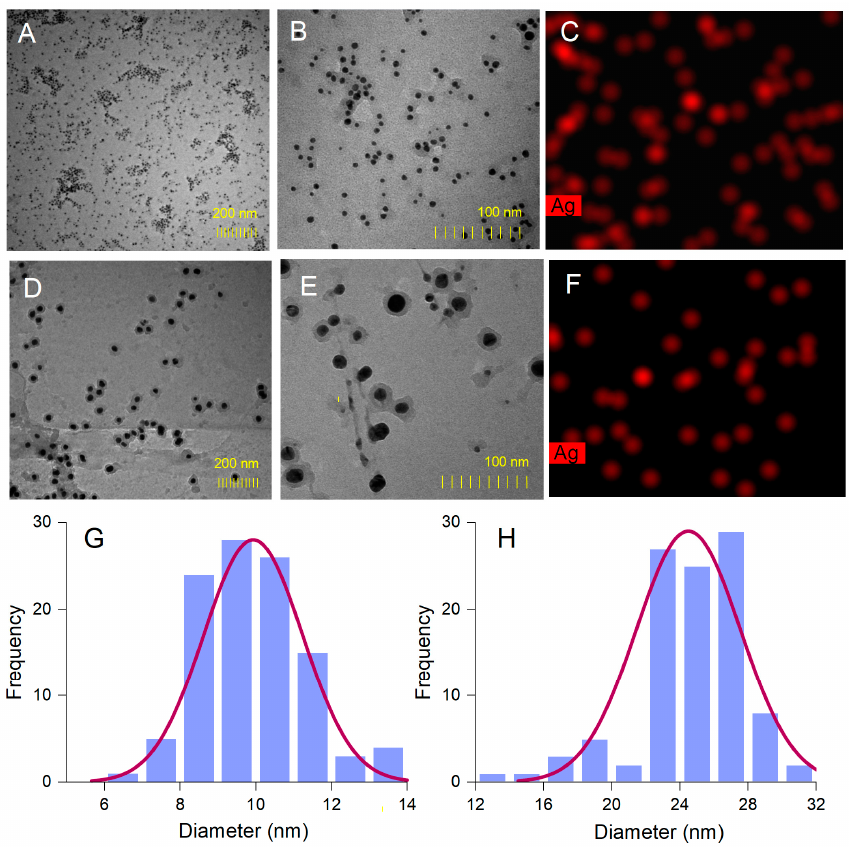
Figure 5. Abies alba bark extract-derived AgNPs: TEM images ( A , B ), TEM-EDX mapping ( C ), size- distribution histogram ( G ); Pinus sylvestris bark extract-derived AgNPs: TEM images ( D , E ), TEM-EDX mapping ( F ), and size-distribution histogram ( H ).